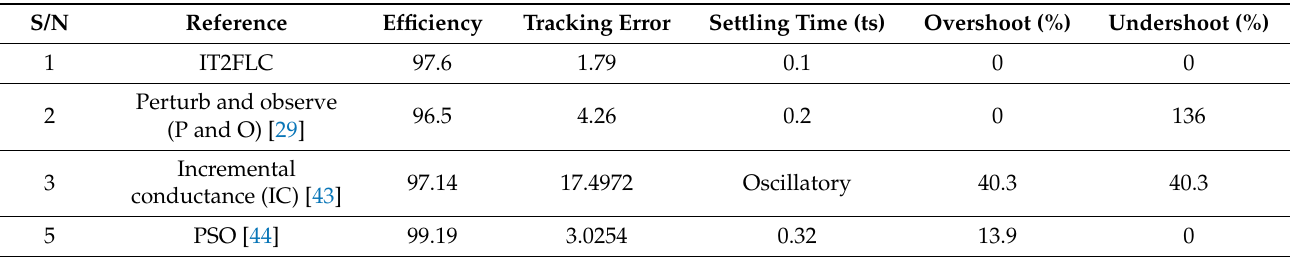
Table 4. Voltage Response Comparison between